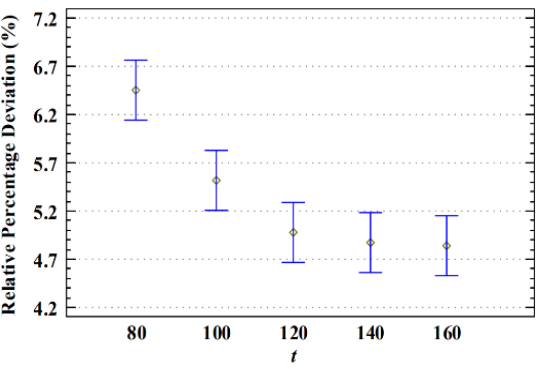
Figure 3. The mean plot of the initial temperatures with 95.0 percent Tukey HSD (Honestly Significant Difference) intervals.